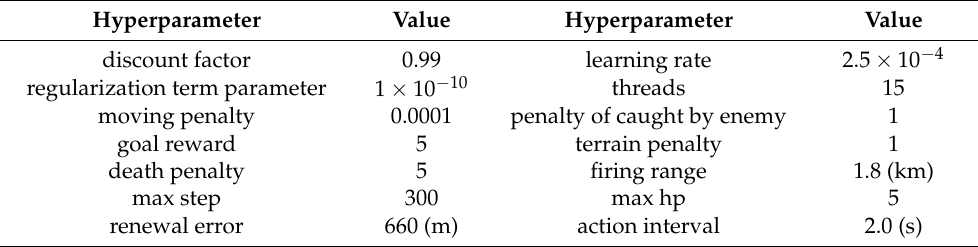
Table 2. Hyperparameters